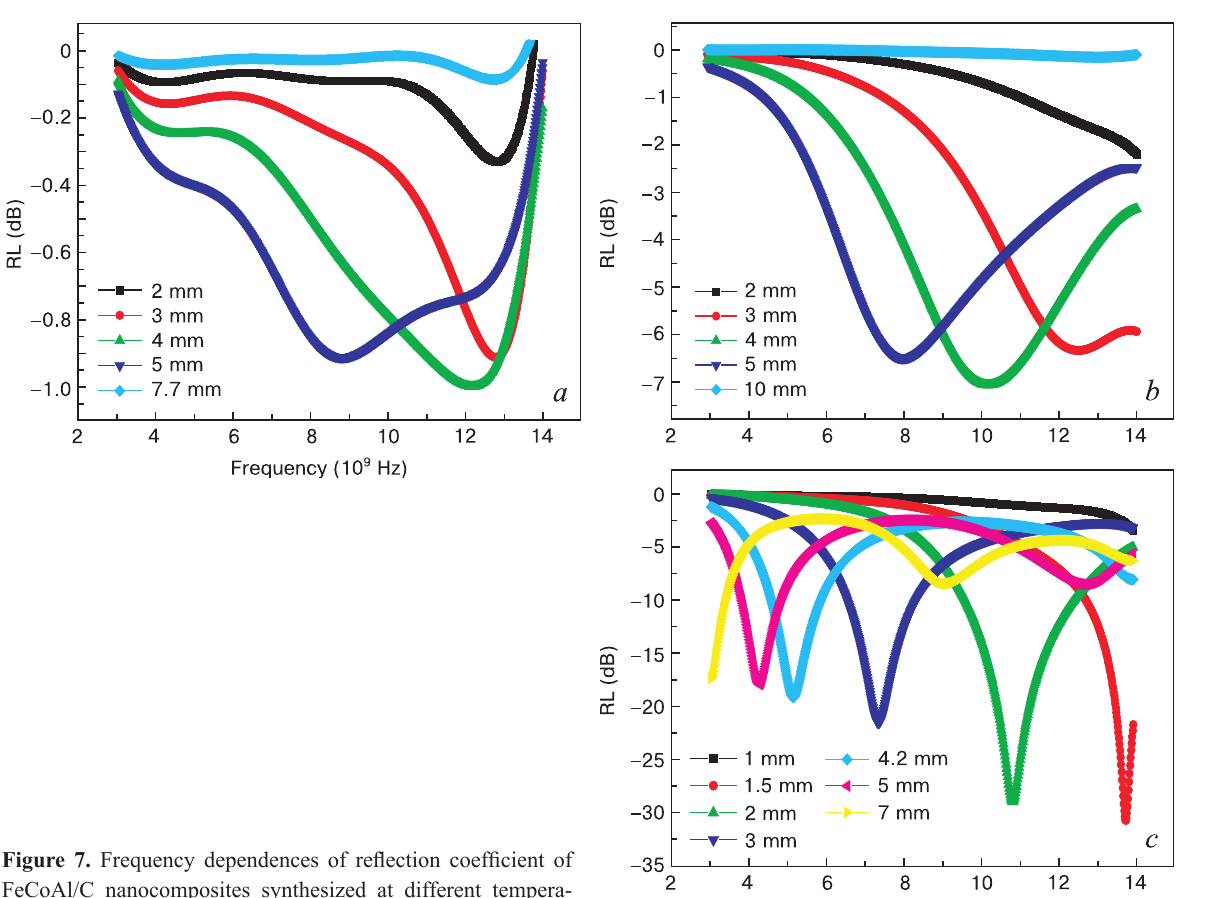
Figure 7. Frequency dependences of reflection coefficient of FeCoAl/C nanocomposites synthesized at different tempera - tures T synth , °C: ( a ) 500, ( b ) 600 and ( c )